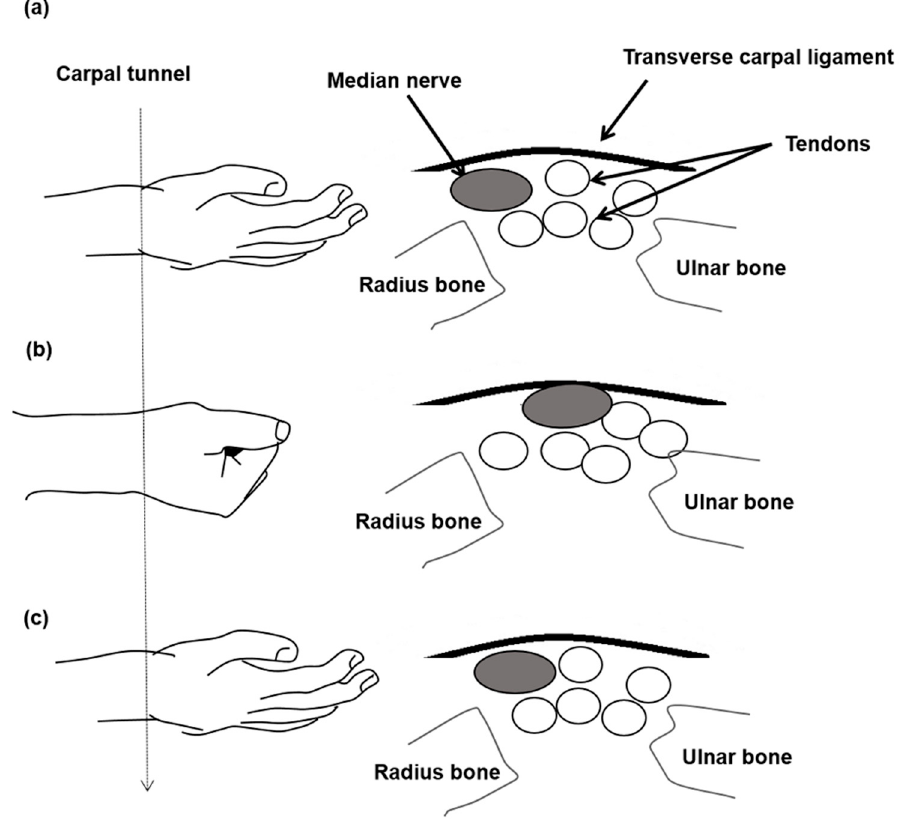
Figure 1. A scanned median nerve movement cycle consisted of a series of finger movements from ( a ) neutral posture to ( b ) fist clenching (finger flexion, acquisition time 1 s) and then to ( c ) palm opening (finger extension and acquisition time 2 s).